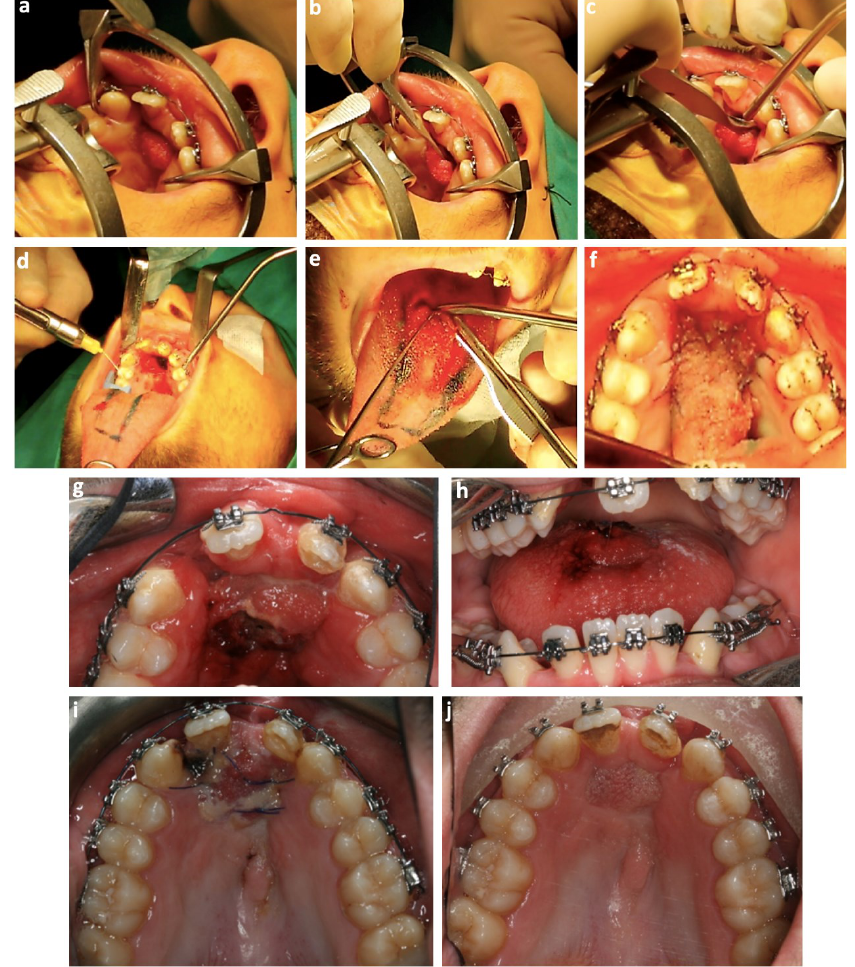
Figure 4. Intraoral photographs of the tongue flap: surgery ( a ) preparation of the operative field; ( b ) and ( c ) de-epithelized the fistulae edges; ( d ) anesthesia of the surgical tongue area; ( e ) tongue graft harvest; ( f ) tongue flap suture to the edges of the palatal defect; separation of the tongue pedicle ( g , h ); post-operatory photographs after 5 weeks ( i ) and 1 year ( j ). After the graft surgery, in the maxillary arch a 0.016 × 0.022 stainless steel archwire was used to line up the maxillary dentition in a more mesial position by sliding mechanics with open-coil spring activation, replacing the absent lateral maxillary incisors for the ca- nines. The mesialization of all posterior maxillary teeth was achieved by the use of elastic chains and Class III intermaxillary elastics when steel arch wires where place in both den- tal arches.